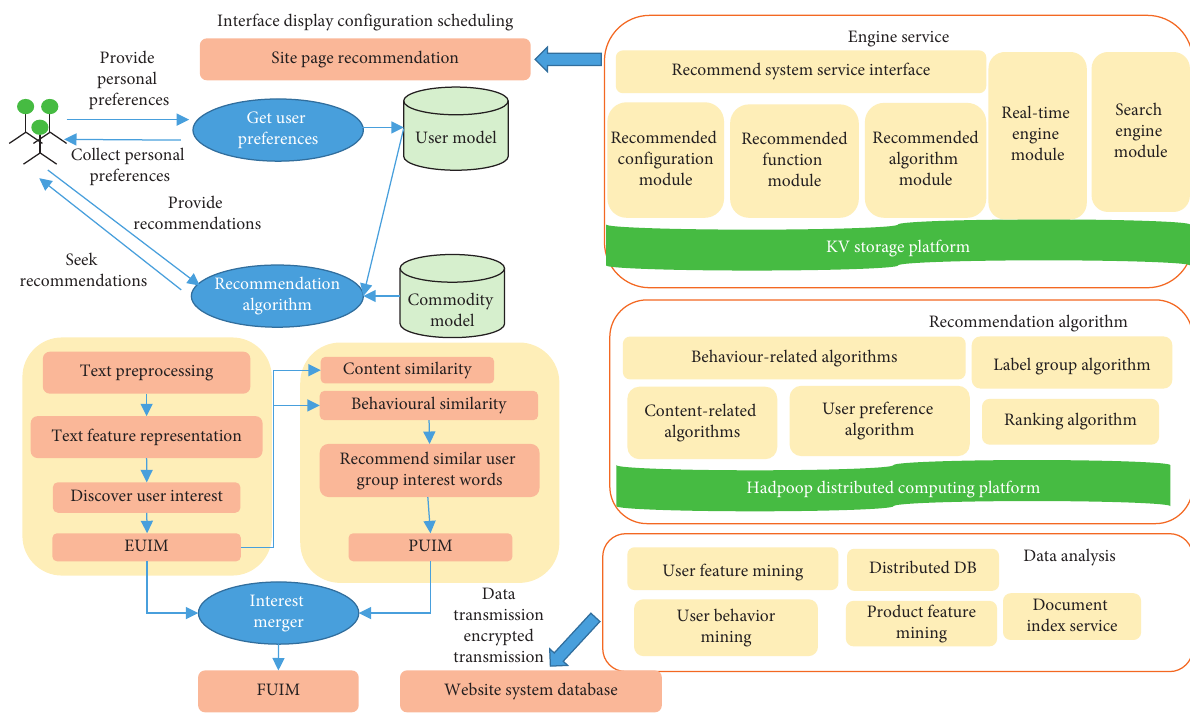
Figure 2: Fusion model construction